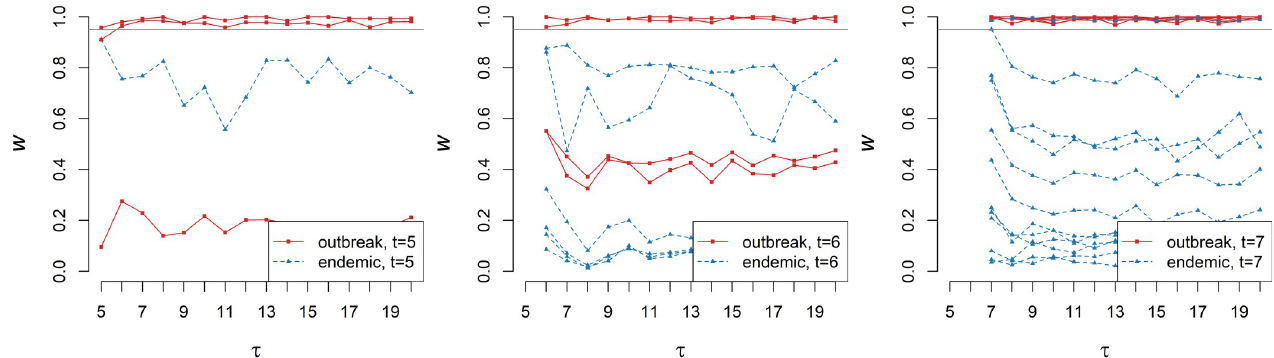
Fig 3. Timeliness. As the time τ progresses and new cases and cylinders are added, the warning-score values of cases previously detected (here at t = 5,6,7, see also Fig 2) are updated. In fact, these converge quickly and even the earliest warning values are